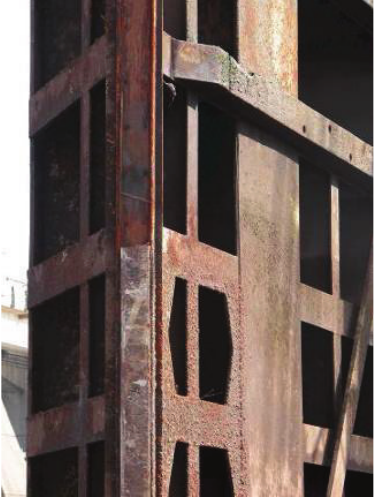
Figure 3: Quoin block failure.